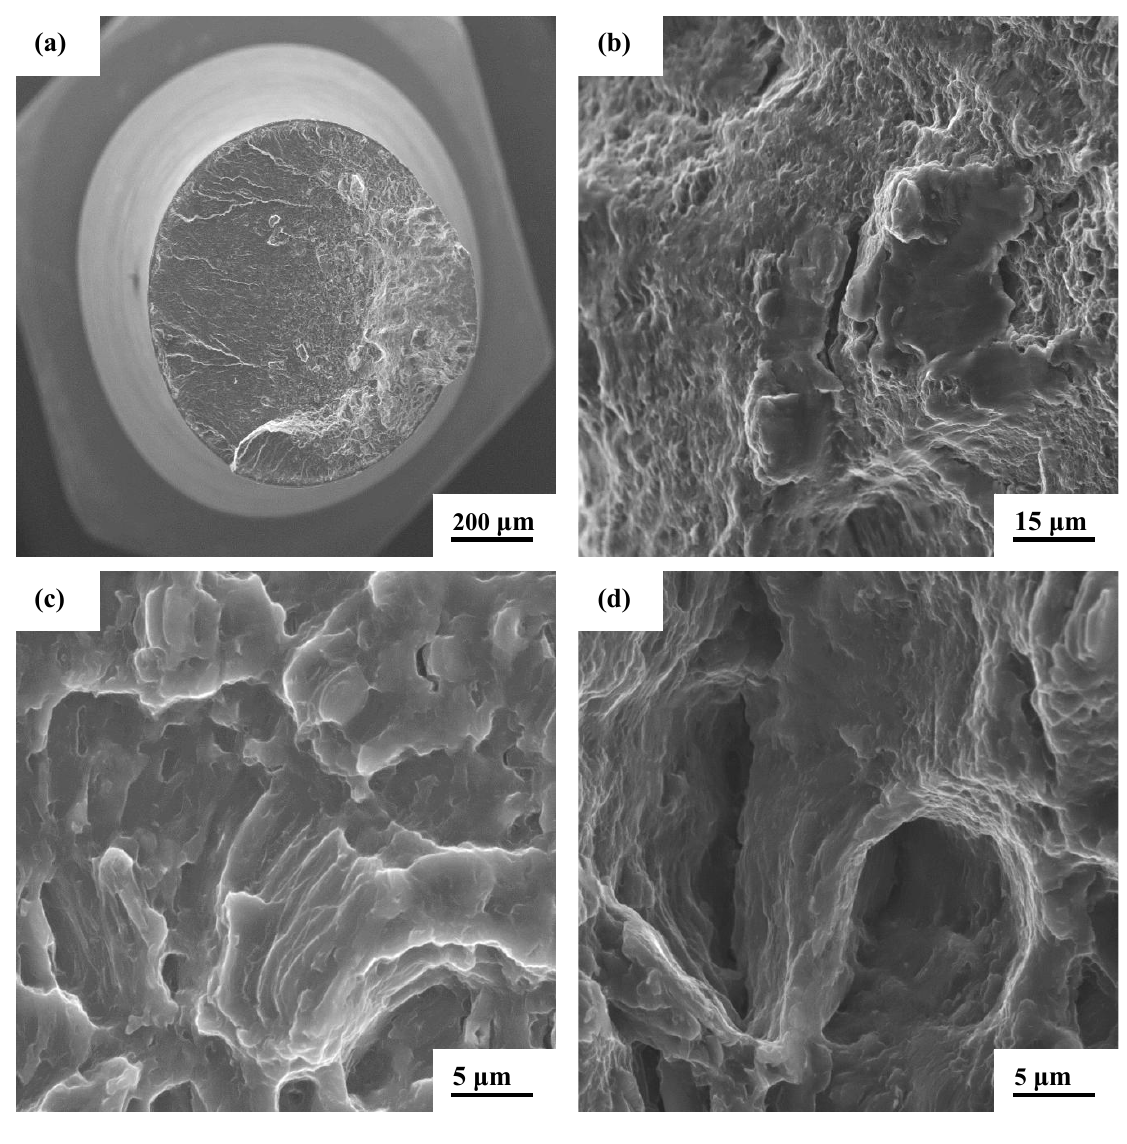
Figure 9. Scanning electron micrographs of the high cycle fatigue fracture surface of O containing 1.5 wt pct nickel deformed at maximum cyclic stress of AZ31 + Al 2 3 113.11 MPa at load ratio of 0.1, fatigue life of 805,217 cycles, showing the